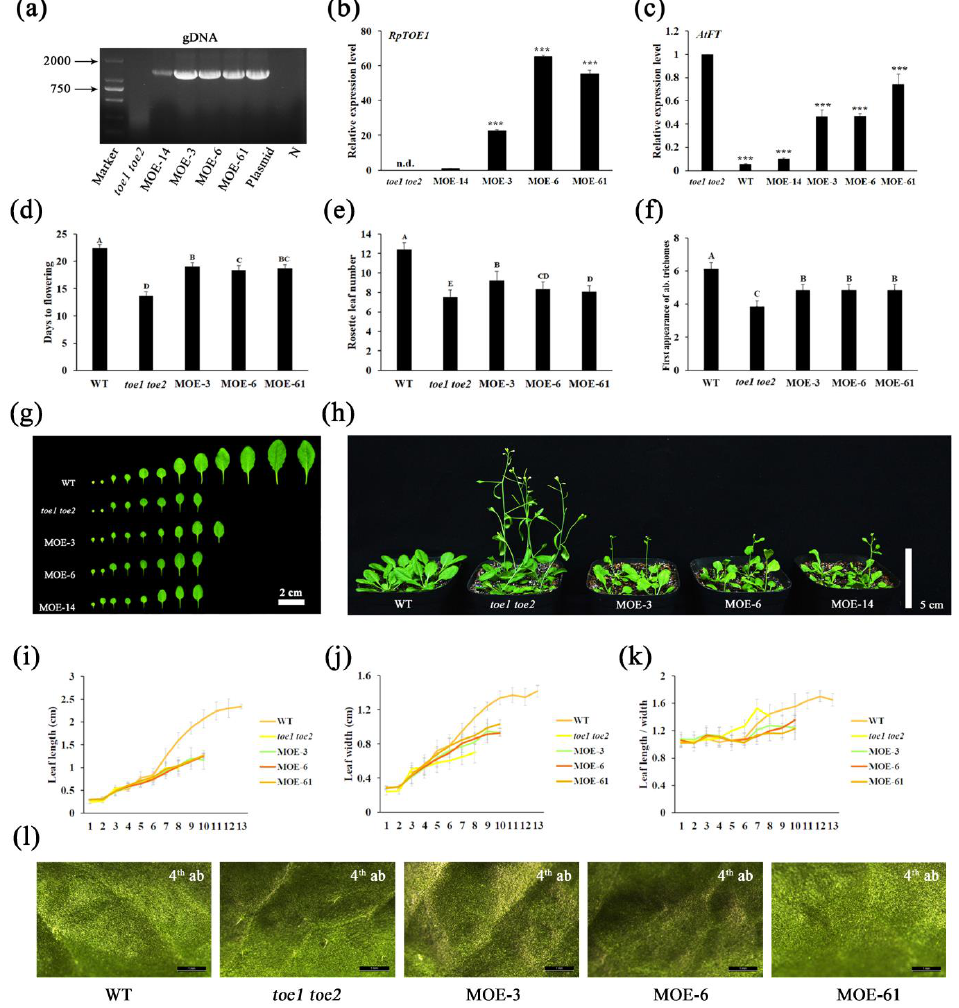
Figure 4. Overexpression and identification of RpTOE1 in Arabidopsis toe1 toe2 mutants. ( a ) PCR analysis of RpTOE1 genes from the genomic DNA of toe1 toe2 double mutants and four transgenic lines; ( b ) Relative expression of RpTOE1 in toe1 toe2 double mutants and four transgenic lines with AtACTB as an internal control using qRT-PCR. Data represent the average of three biological replicates; ( c ) Relative expression of the AtFT gene in toe1 toe2 double mutants, wild-type (WT), and four transgenic lines. ( d ) Days to flowering of WT, toe1 toe2 double mutants and transgenic lines; ( e ) Rosette numbers when floral primordia were visible; ( f ) The abaxial (ab) trichome statistics. The first leaf with abaxial trichomes was scored ( n >20); ( g ) All rosette leaves on one plant of WT, toe1 toe2 double mutants and transgenic lines when floral primordia were visible in toe1 toe2 double mutants; ( h ) Phenotype of the WT, toe1 toe2 double mutants and RpTOE1 -overexpressing plants in toe1 toe2 double mutants; ( i – k ) Leaf shape measurement when floral primordia were visible. The x-axes indicate the order of leaves. The y-axes indicate leaf length ( i ); leaf width ( j ); and leaf length/width ratio ( k ); ( l ) The abaxial trichome phenotype. MOE-14, MOE-3, MOE-6, and MOE- 61represent RpTOE1 -overexpressing plants in toe1 toe2 double mutants. N, negative control using water as a template. The expression levels were quantified in 15-day-old seedlings. *** significant differences between the MOE-14 line and toe1 toe2 double mutants based on Student’s t -test ( p < 0.001). n.d. = not detected. Capital letters designate groups that significantly differ ( p < 0.01). Error bars represent SEM. Bar = 2 cm in ( g ), bar = 5 cm in ( h ) , and bar = 1 mm in ( l ). n > 30 in ( d , e , i – k